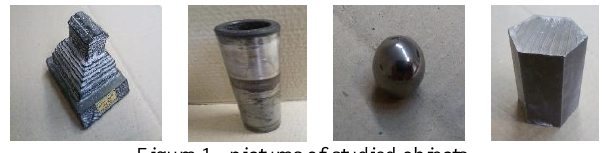
Figure 1 –pictures of studied objects